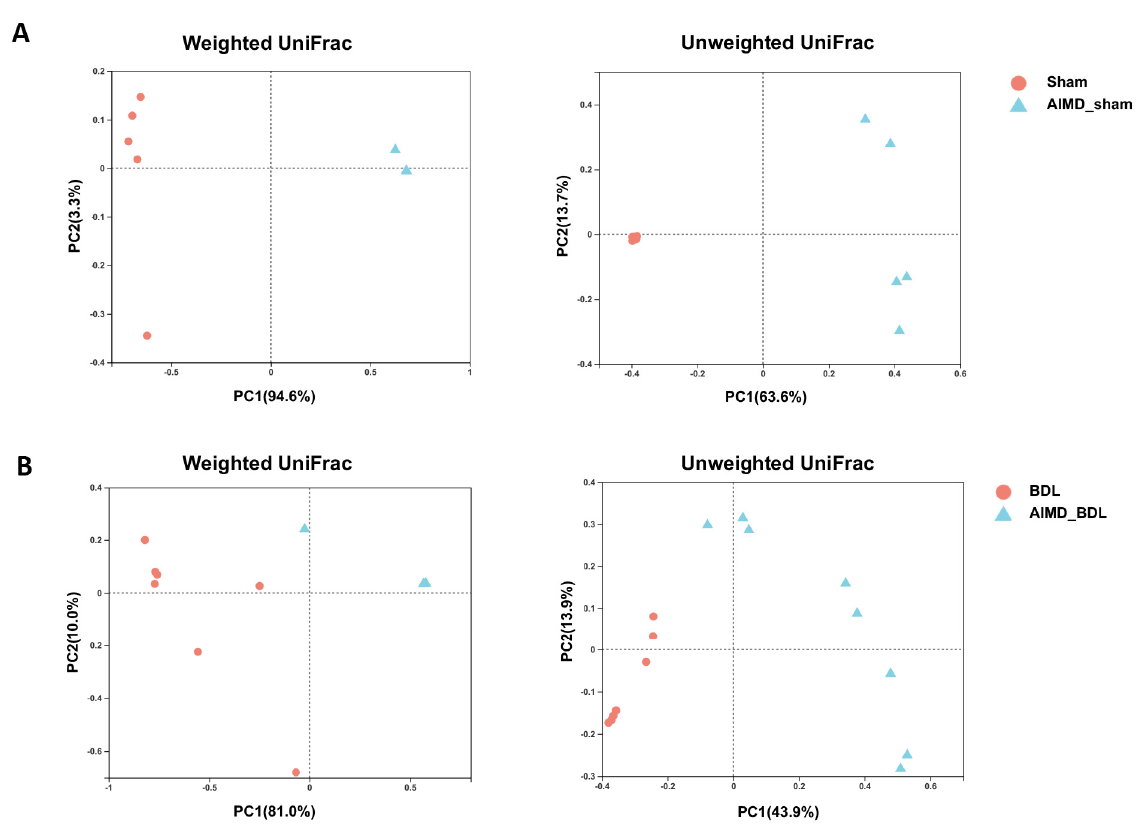
Figure 4. ( A ) Unweighted and weighted UniFrac distances showed obvious difference in gut microbiotic composition between Sham group ( n = 5, red plots) and AIMD_Sham group ( n = 5, blue plots). ( B ) Unweighted and weighted UniFrac distances showed obvious difference in gut microbiotic composition between BDL group ( n = 7, red plots) and AIMD_BDL group ( n = 8, blue plots).